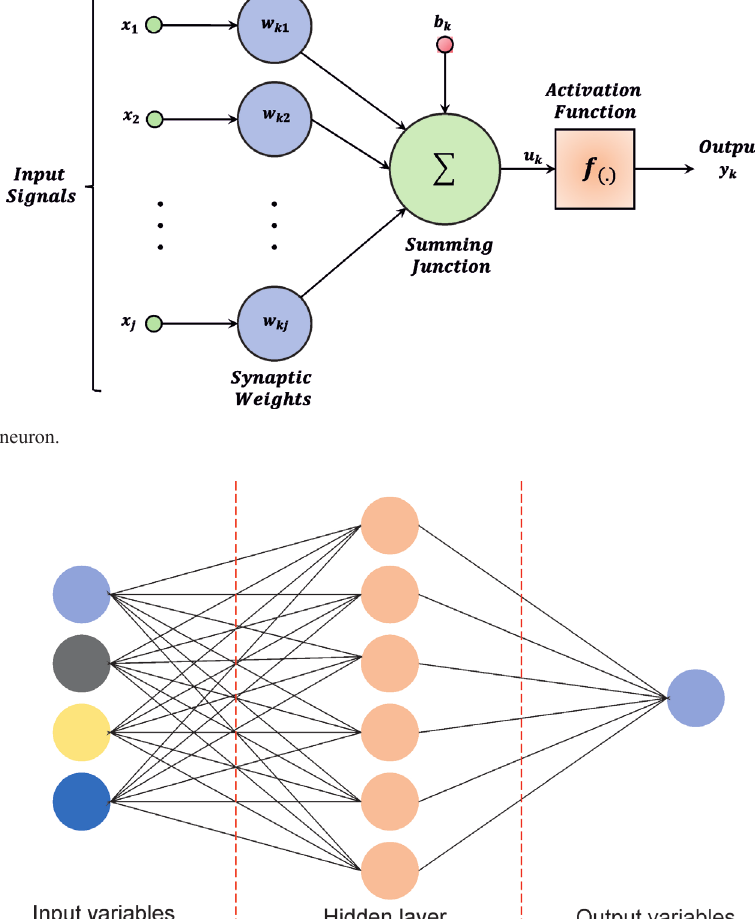
Figure 2. Feed-forward single-layer artificial neural